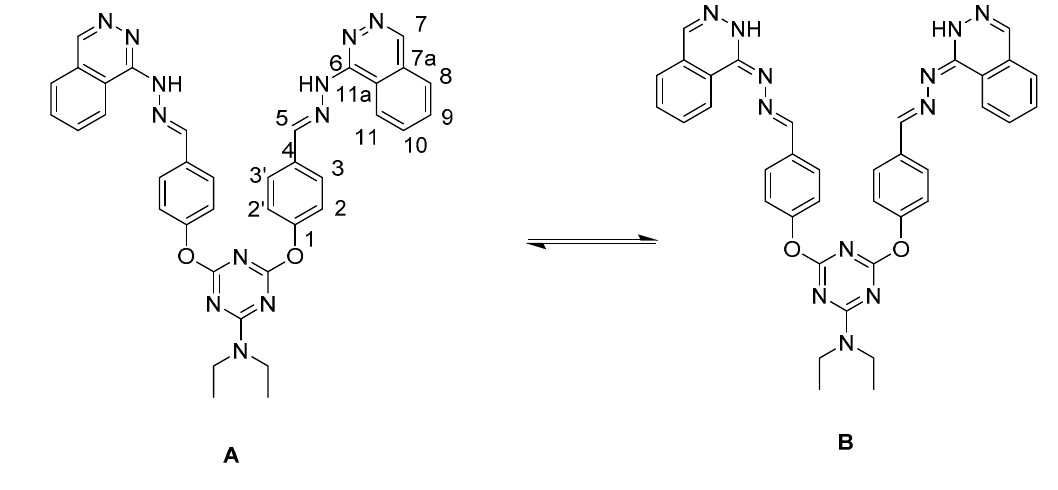
Figure 1. Structure of compound 11c .